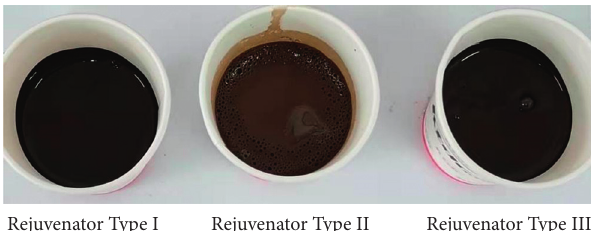
Figure 1: Samples of rejuvenators Types I, II, and